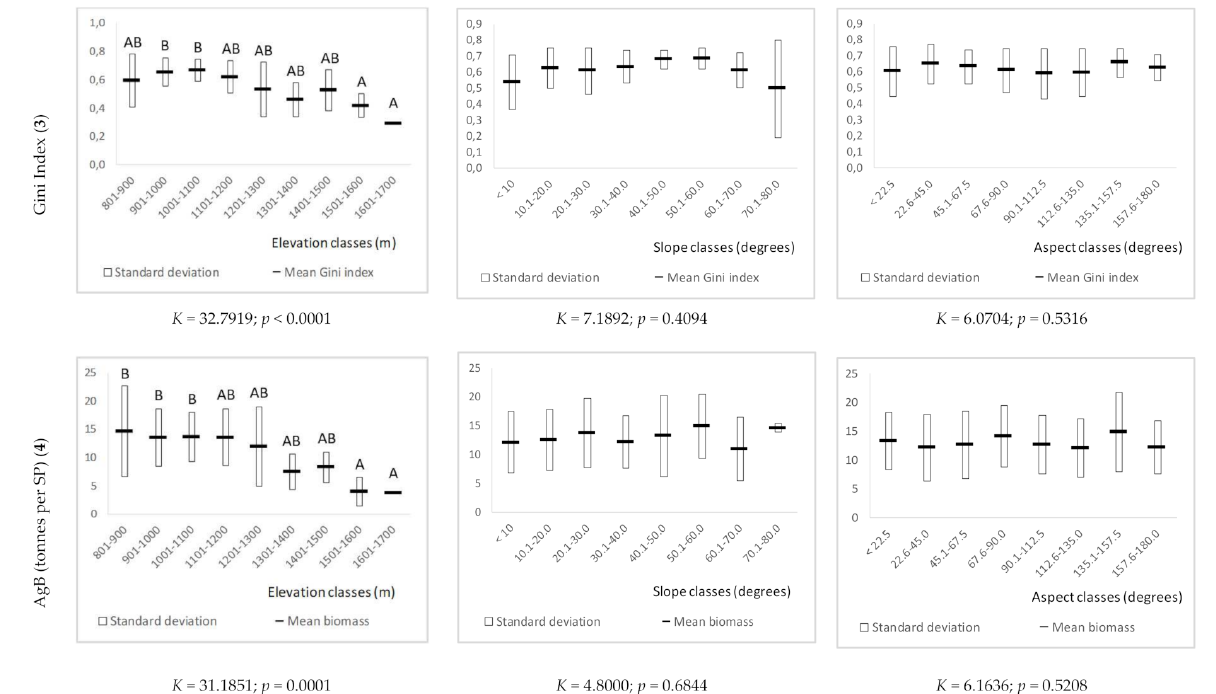
Figure 5. Distribution of tree species number ( 1 ), tree species diversity ( 2 ), tree size heterogeneity ( 3 ), and aboveground biomass of living trees ( 4 ) by elevation class ( a ), slope ( b ) and aspect classes ( c ). Different uppercase letters indicate significant differences between classes according to the Conover–Iman Multiple pairwise comparisons procedure ( p < 0.05); K represents the Kruskal–Wallis constant, while p indicates the significance